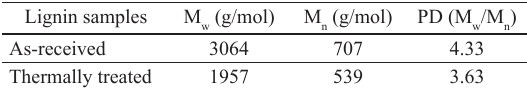
Table 2. The average molecular weight and polydispersity index (M /M ) values of the as-received and thermally treated kraft lignin. w n